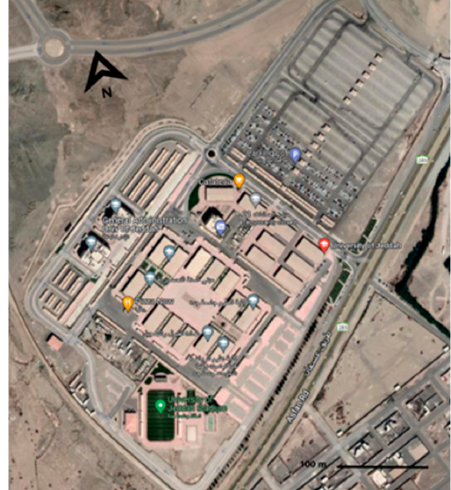
Figure 1. University of Jeddah Campus Latitude (N): 21.89252 degrees, Longitude (E): 39.2539 degrees (image source Google Maps 2021).